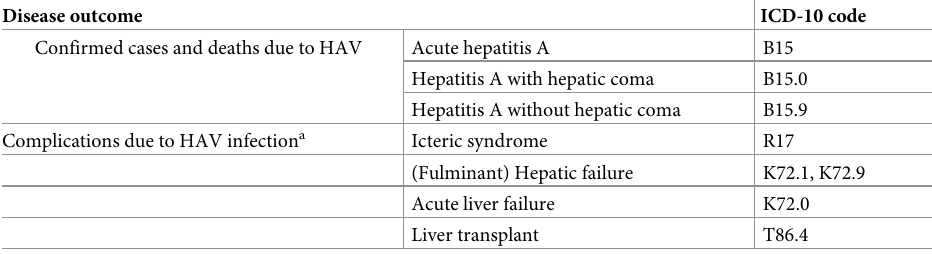
Table 1. Definition HAV-associated disease based on ICD-10 codes [21]. Disease